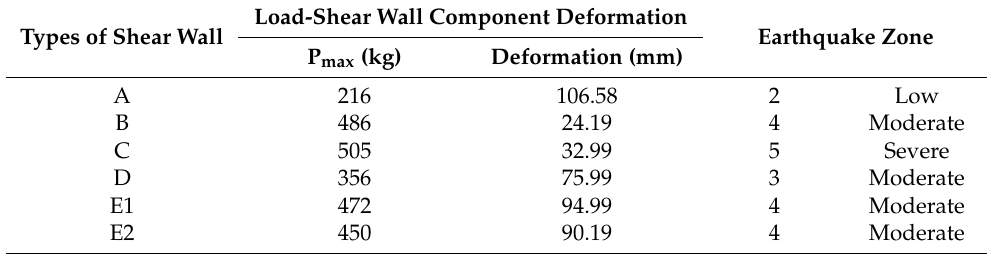
Table 3. Feasibility of shear wall component panels based on the earthquake zone. Types of Shear